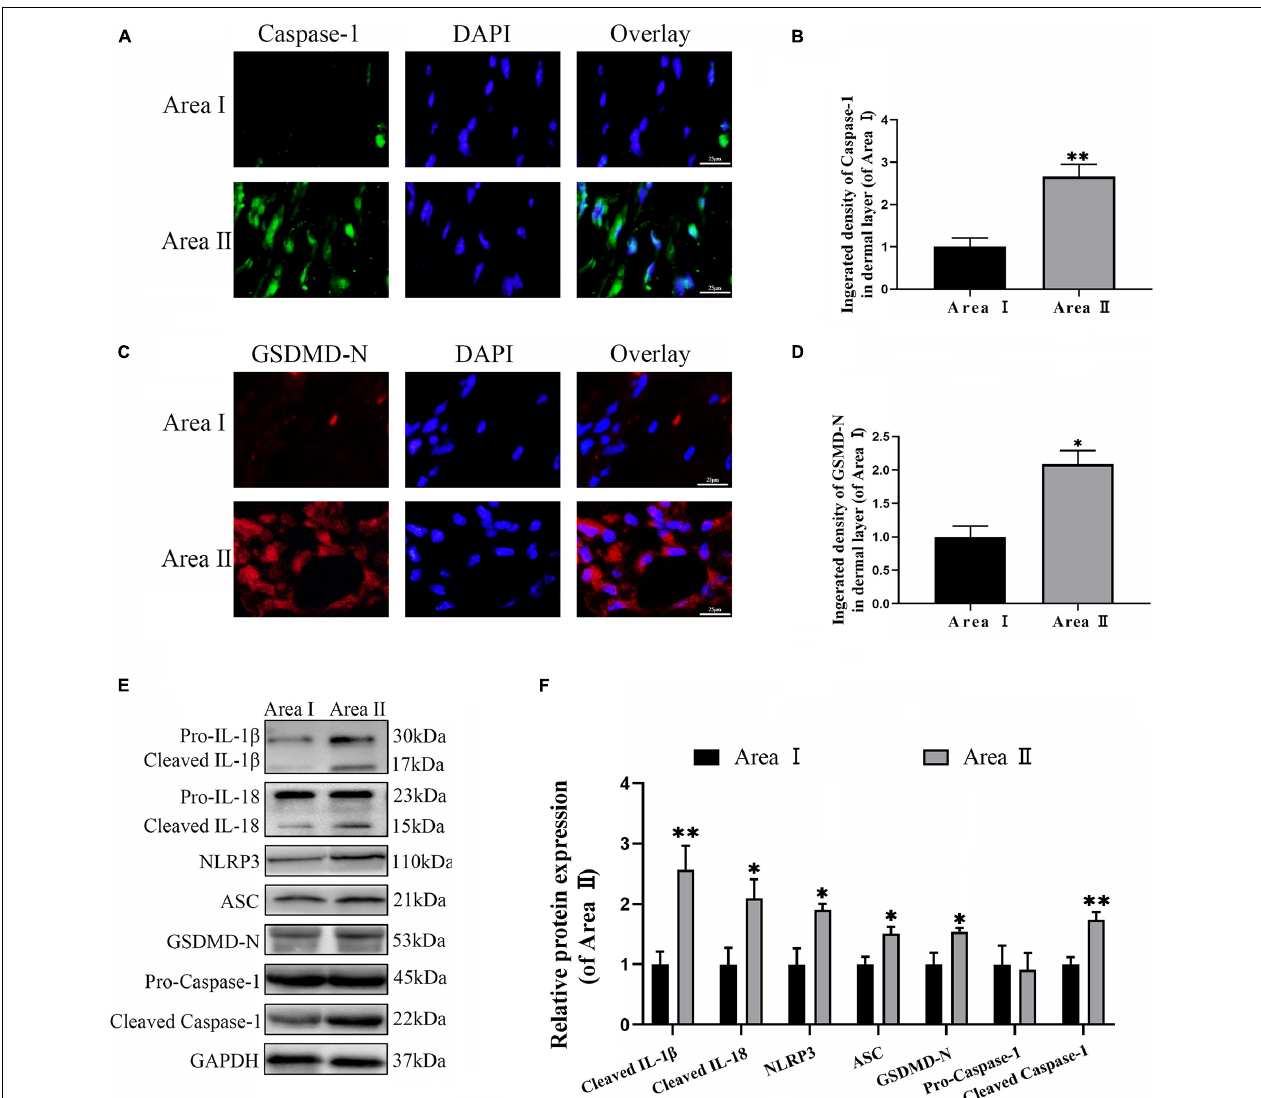
FIGURE 1 | Cell pyroptosis exists in the random skin flap. (A) The levels caspase-1 of the flaps in the area II and area I groups evaluated by immunofluorescence (IF) (scale bar: 25 mm). (B) The fluorescence intensity for caspase-1. (C) Immunofluorescence for Gasdermin D–N-terminal domain (GSDMD-N) in skin flaps (scale bar: 25 mm). (D) The fluorescence intensity for GSDMD-N. (E) Western blotting of pyroptosis related proteins in flap tissue from area II and area I groups. (F) Optical density analysis of pyroptosis related proteins expression. Values represent the mean ± SEM, n = 6 per group. * p < 0.05 and ** p < 0.01, vs. area I